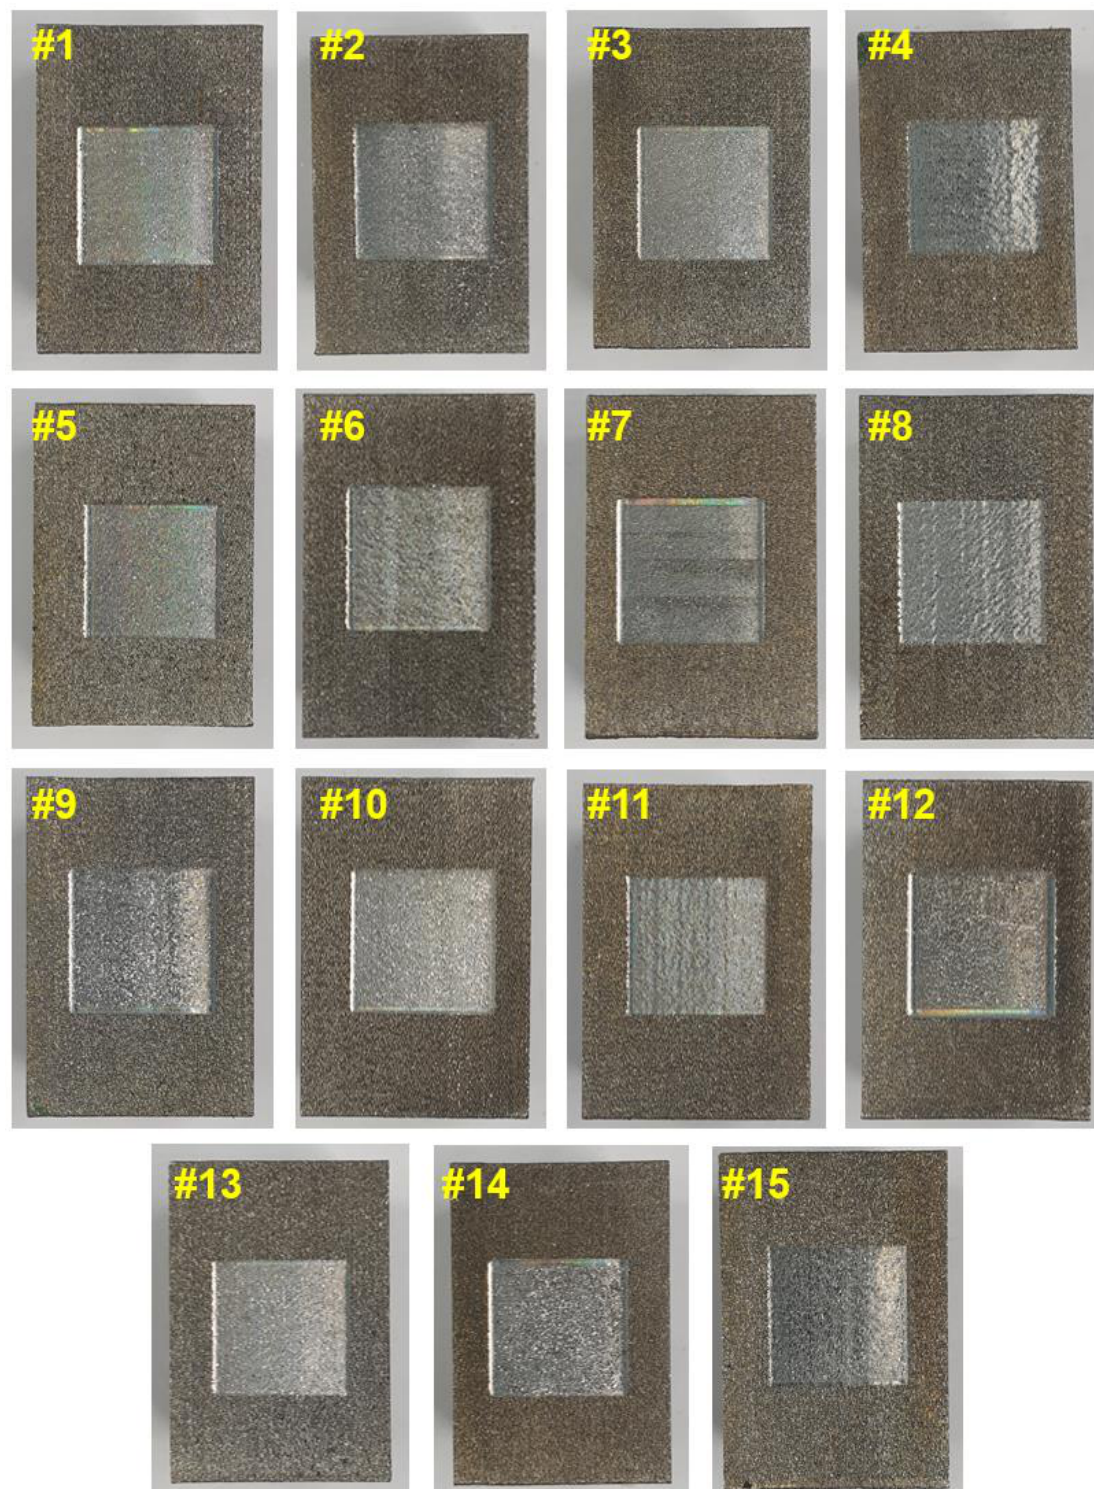
Figure 6. UNSM-treated specimens according to the design of the experiment.